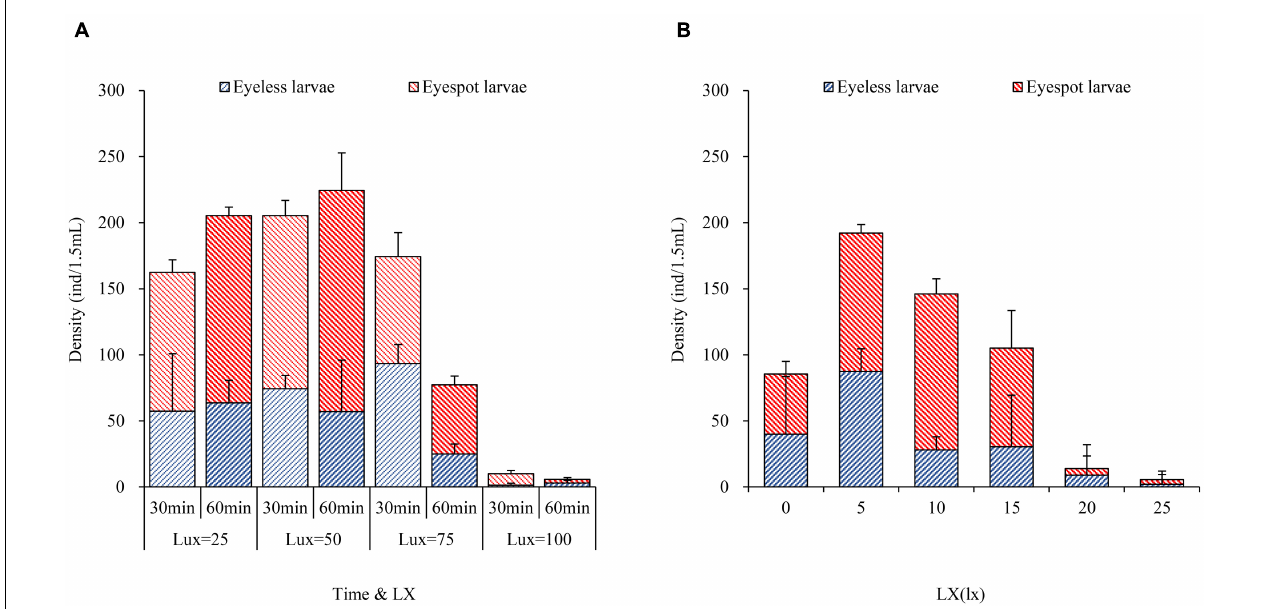
FIGURE 3 | The bar plots of hybrid oyster larvae distribution to light intensity. (A) The density of eyespot larvae and eyeless larvae with time and light intensity. (B) The density of eyespot larvae and eyeless larvae with light intensity.